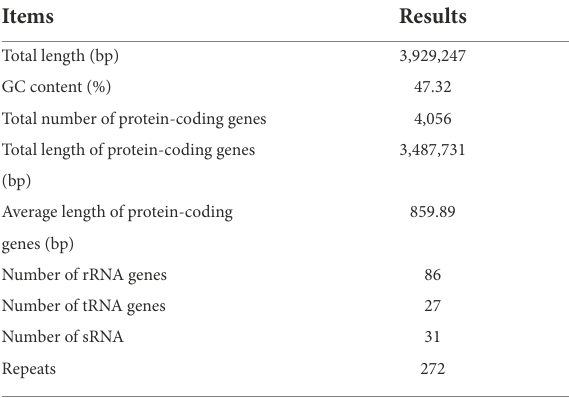
TABLE 2 Statistics of strain E genome